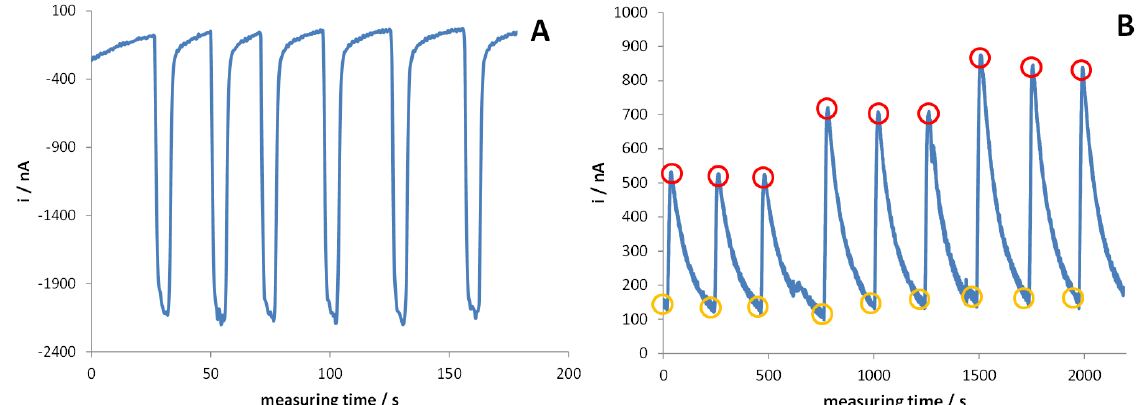
Figure 3. Amperometric measurements of ( A ) six subsequent injection of [Fe(CN) through the NAD + micropump in a flux of 0.05 M PBS and 0.1 M KCl (E = −0.2 V); ( B ) NAD + injections in flux containing glycerol (0.11, 0.19, 0.25 gL −1 – 3 replicates